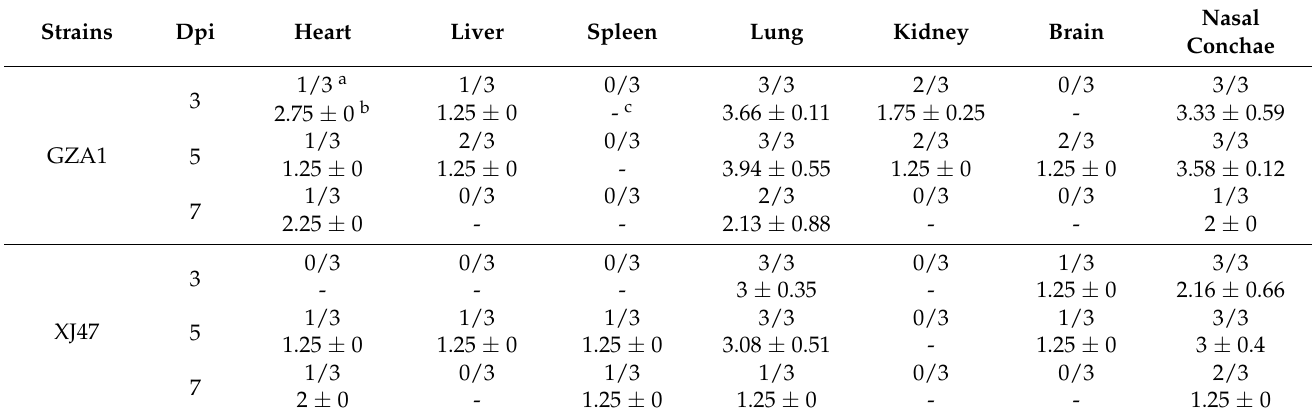
a Virus isolation ratios of the mice infected with AIV. b Values represent average virus titers (log ± standard deviation (SD). c No virus